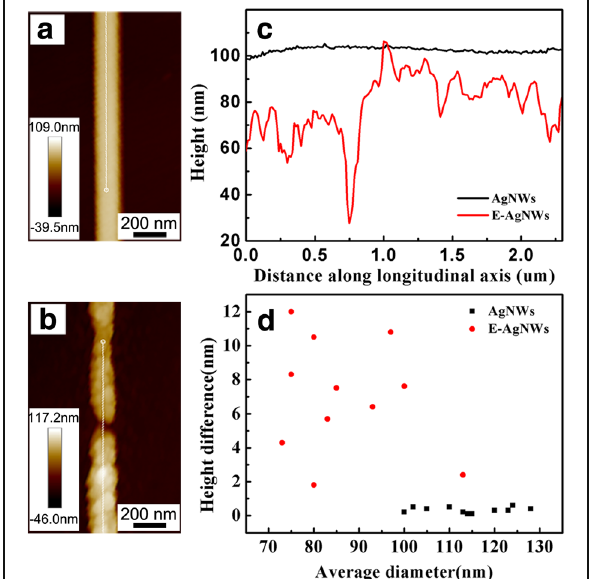
Fig. 4 Normalized UV – vis extinction spectra for the as-synthesized and chemically etched Ag nanowire aqueous solution with different amounts of the etching agent. E200, E300, and E400 stand for the chemically etched Ag nanowires etched by 200, 300, and 400 μ L etchant,